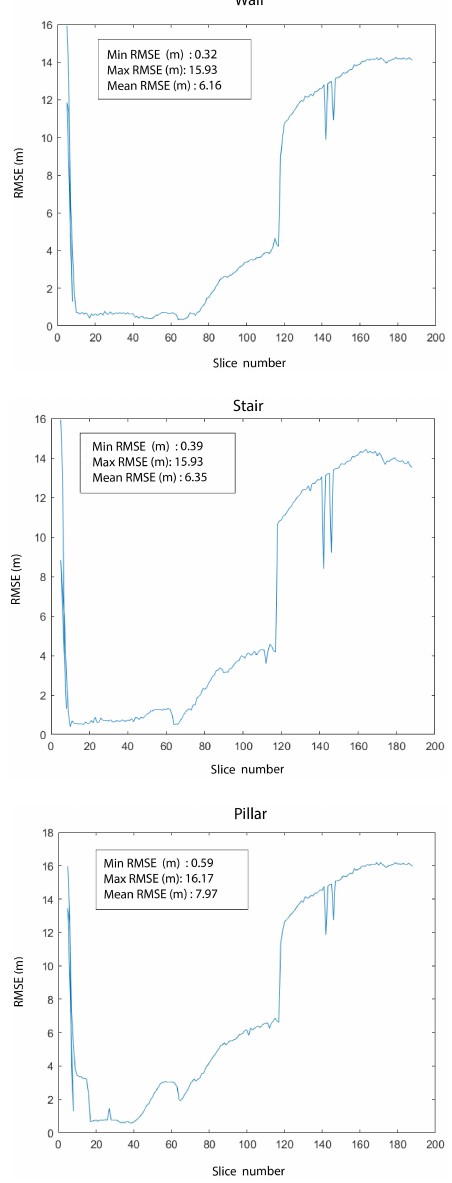
Figure 5. RMSE error on the registration depending on semantic of the